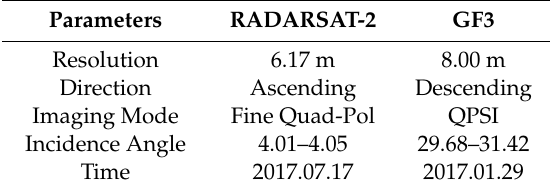
Table 4. The Parameters of RADARSAT-2 and GF3.